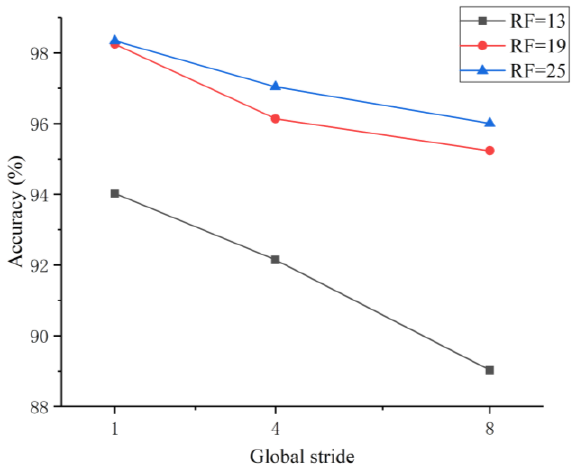
Figure 3. Comparison of identification accuracy of models under different